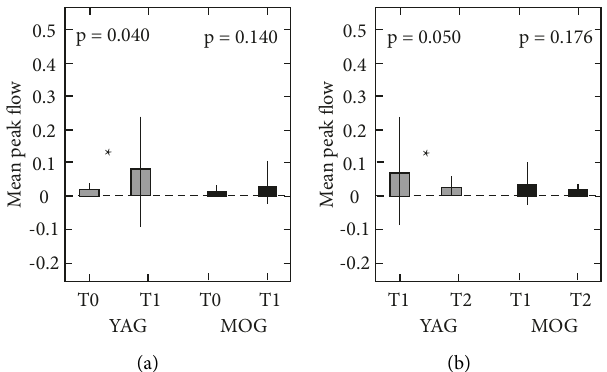
Figure 4: Mean peak flow measured in the masseter. Numeric values are shown as the means ± SDs. ∗ p < 0 . 05 comparing (a) T 0 and T 1 and (b) T 1 and T 2. T 0, before the task; T 1, immediately after the task; T 2, five minutes after T 1; YAG, young adult group; MOG, middle-aged to old group.